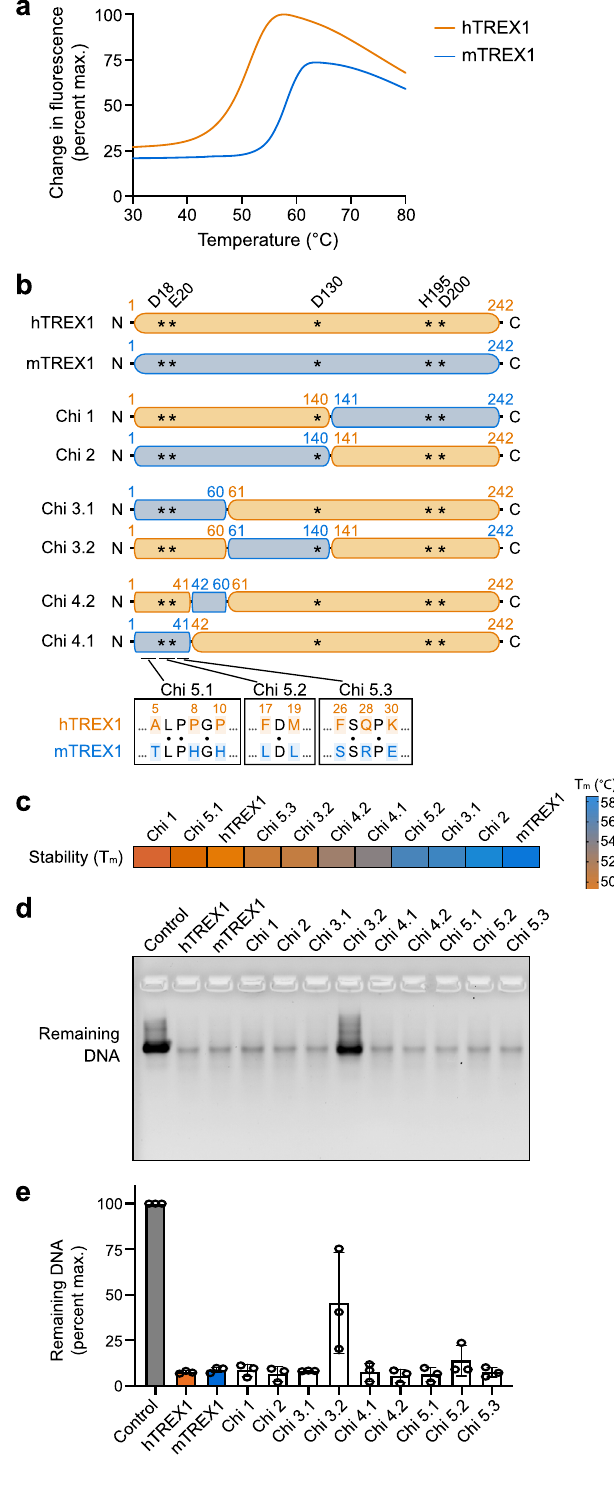
DNA5 ′ end(Fig.3bandSupplementaryFig.4b).hTREX1K160andR164 reside in α -helix 7 and make direct contact with the DNA phosphate